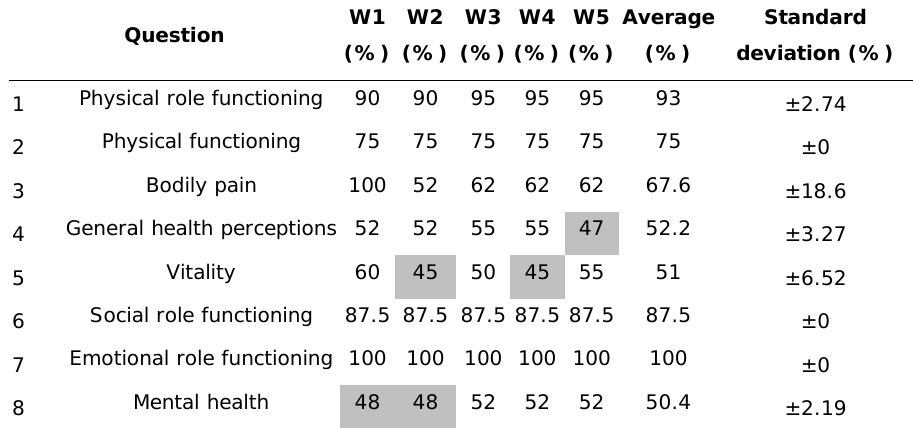
Table 3. Results from the Life Quality